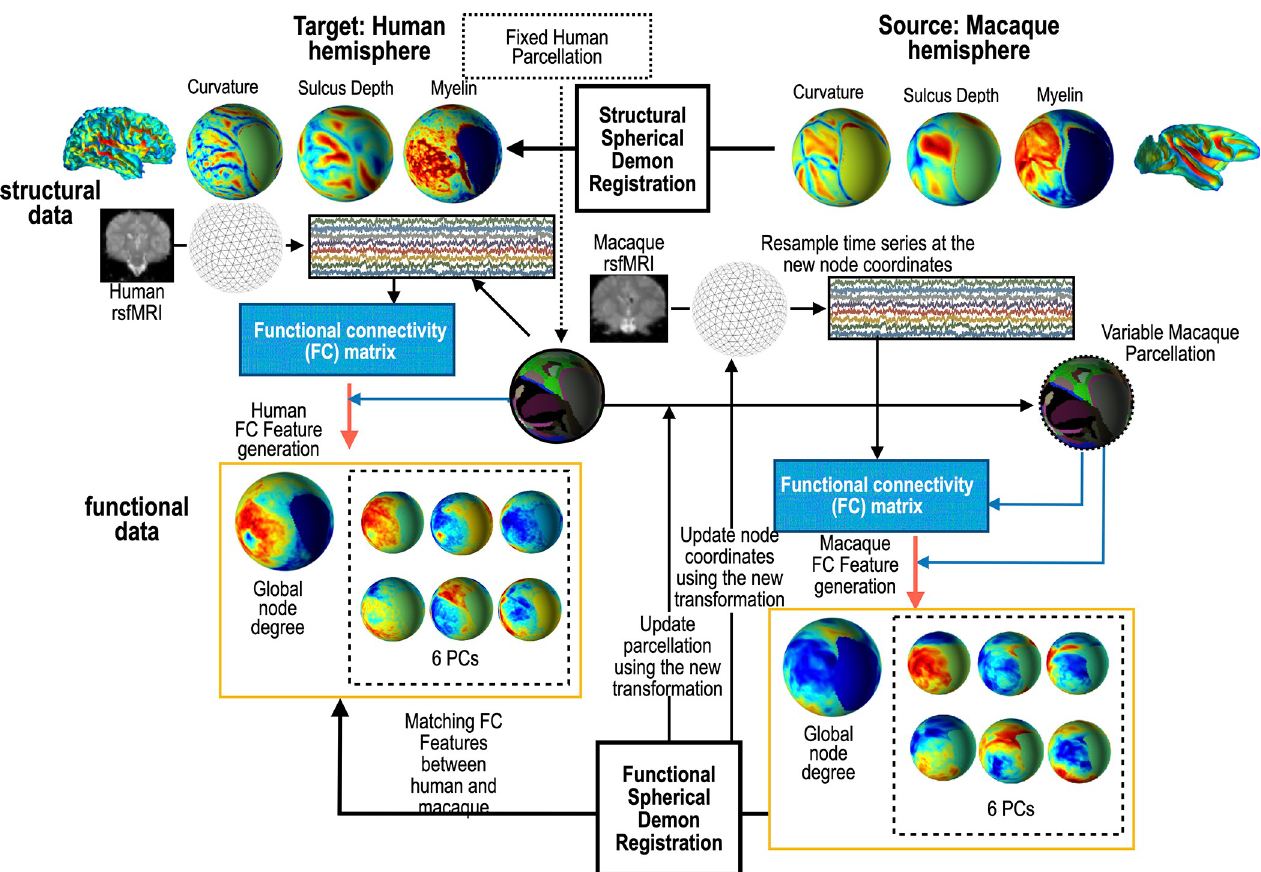
Fig 4. The proposed spherical registration algorithm between macaque and human hemisphere. For each iteration of the proposed algorithm, curvature, sulcus depth, myelination, node degree, and six group principal components based on functional connectivity matrix were generated and used in the demons